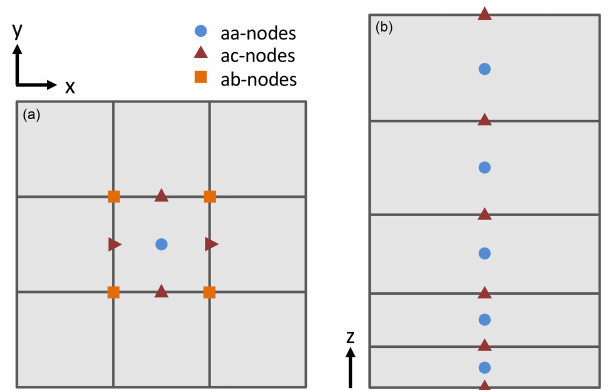
Figure 2. Yelmo staggered grid definition and nomenclature. The (a) horizontal grid assumes constant resolution in the x and y direc- tions, while in the (b) vertical variable resolution is allowed. With any given cell defined as a 3D box, scalar variables are calculated on cell centers (aa-nodes), velocities are calculated on cell faces (ac-nodes, edges in 2D), and scalar coefficients are calculated on cell edges (ab-nodes, corners in 2D). Figure design adapted from Hoffman et al.